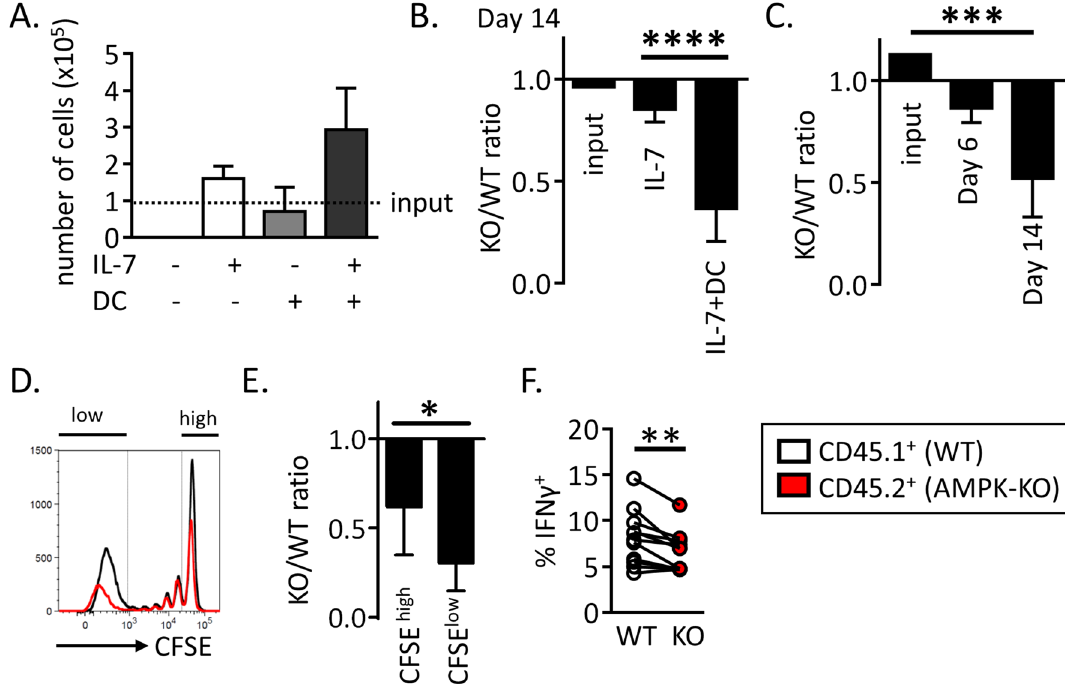
Figure 3. AMPK promotes homeostatic proliferation in vitro. ( A ) Naive Th cells from C57BL/6 mice were cultured in the presence of IL-7 and/or syngeneic DCs, as indicated. Culture media were replaced with fresh DCs and IL-7 each 4–5 days. Results indicate the numbers of T cells recovered on day 18, with dashed line corresponding to the number of cells in the input culture (day 0) (data are pooled from 2 independent experiments, n = 3–6). ( B ) Relative recovery of AMPK-KO T cells after 14 day-culture with IL-7 in the presence or absence of syngenic DC. ( C ) Relative recovery of AMPK-KO T cells at day 6 and 14 of IL-7 + DC culture. ( D ) CFSE dilution profiles of WT and AMPK-KO at day 14 of IL-7 + DC culture. ( E ) Relative contribution of AMPK-KO T cells according to CFSE content. ( F ) Percentage of WT and AMPK-KO T cells expressing IFNγ at day 14. Data are representative of at least 5 experiments with n = 17 ( B ) or 8 ( C ), or are pool of 2 independent experiments with n = 3–6 ( A ), 13 ( E ) or 11 ( F ). Statistical analysis: Mann–Whitney ( B ), Friedman followed by Dunn multiple comparison ( C ) Wilcoxon ( E – F ). *p < 0.05; **p < 0.01; ***p < 0.001; ****p <